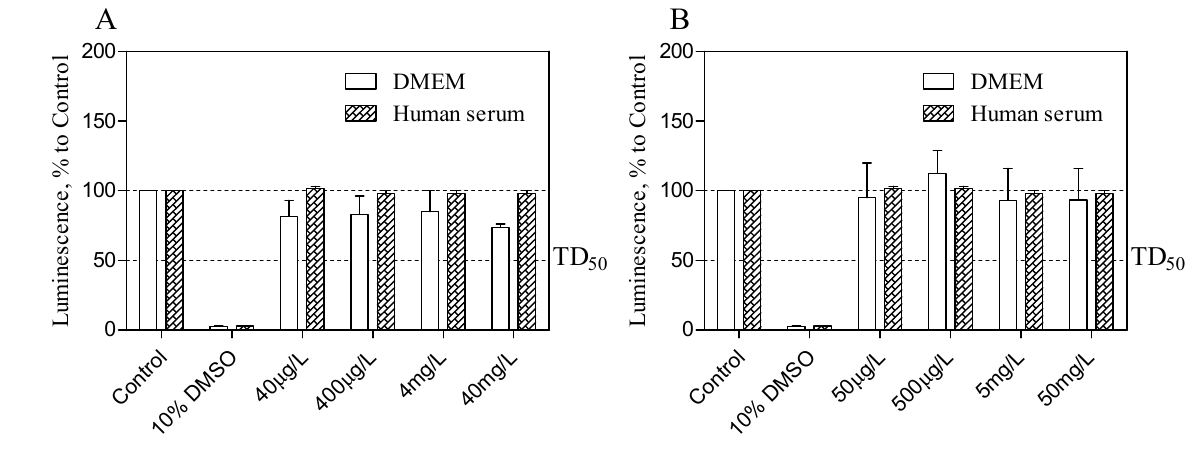
( B ) toxic effects on the cEND cells over time (24 h). The luminescence is measured in percentage to a control group contained untreated cells. 10% solution of dimethyl sulfoxide (DMSO) was used as a positive control. The median toxic dose level is abbreviated as TD 50 . The thresholds are depicted as dashed lines. The data represent means ± S.D. of